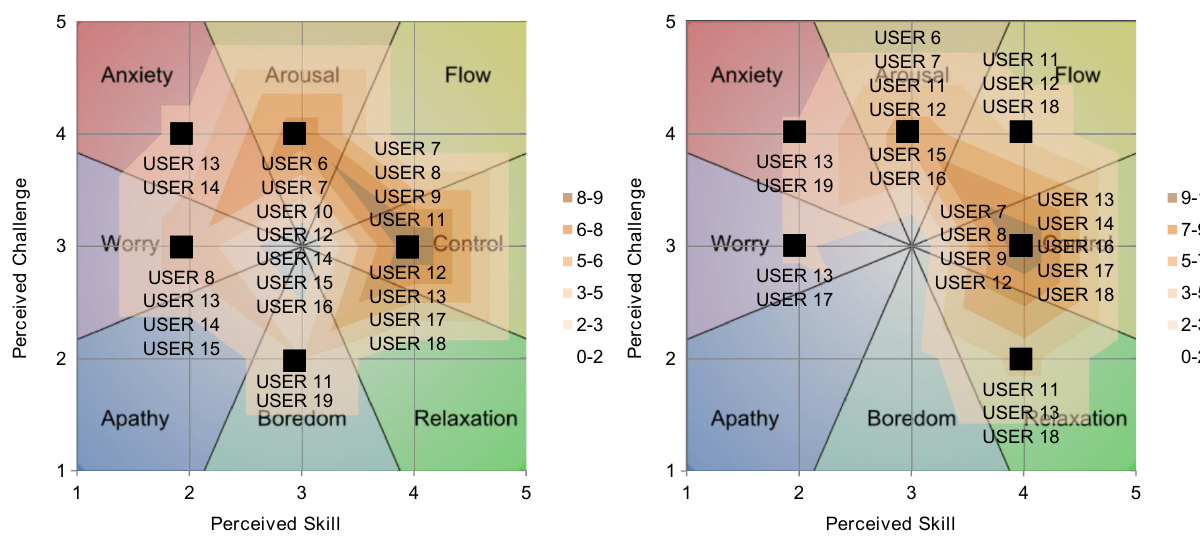
Figure 10: Flow Condition findings by user feelings (TGUI)